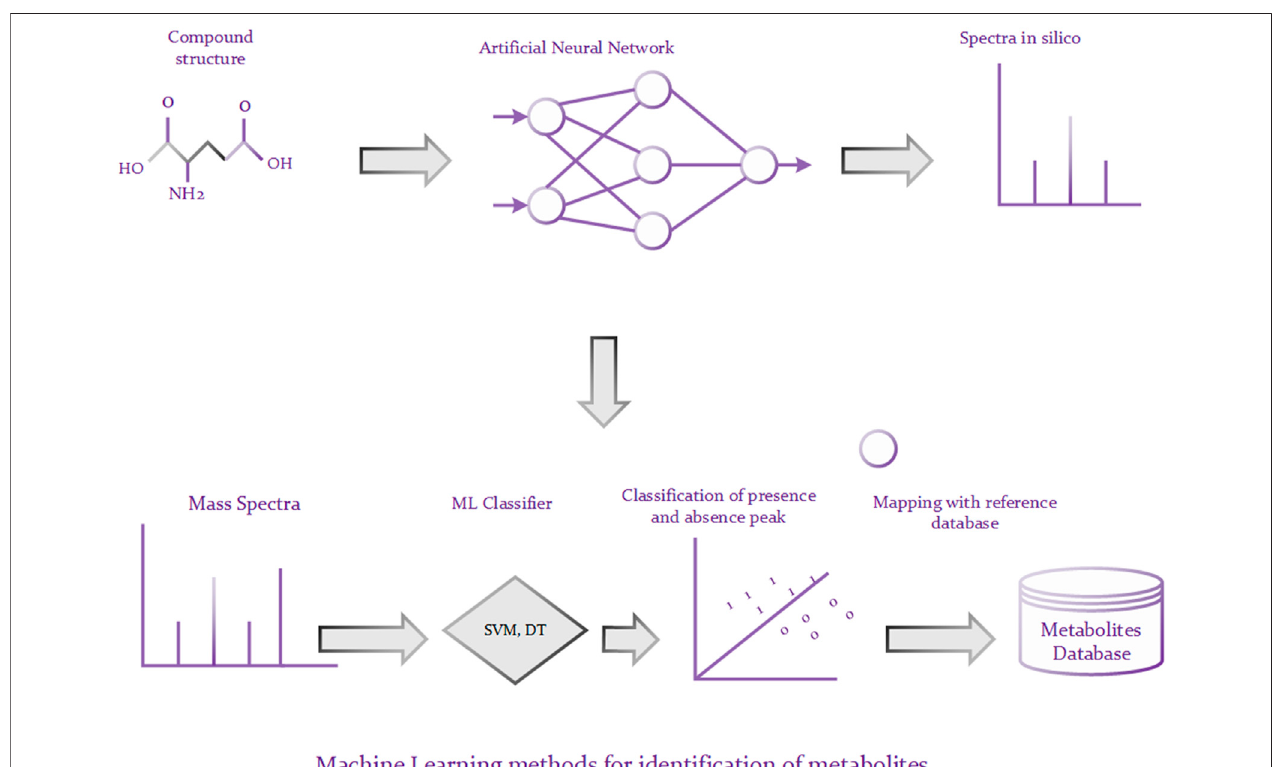
FIGURE 3 | Prediction of metabolites using ML